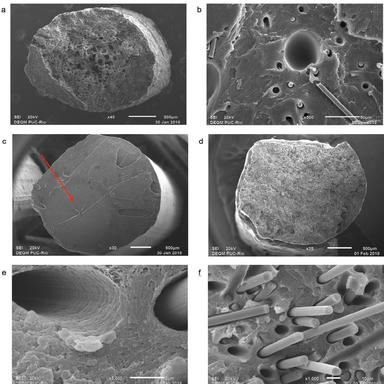
(a) surface of a pellet (Mixture V); (b) surface of a pellet at high magnification (Mixture II); (c) surface of a fractured neat ABS sample (Mixture I) with an arrow indicating a fracture initiation site; (d) fractured surface of a sample with high % wt CF (Mixture V); (e) hole left from a pulled-out fiber and empty space around a fiber (Mixture V); (f) random fiber distribution and interaction (Mixture V).